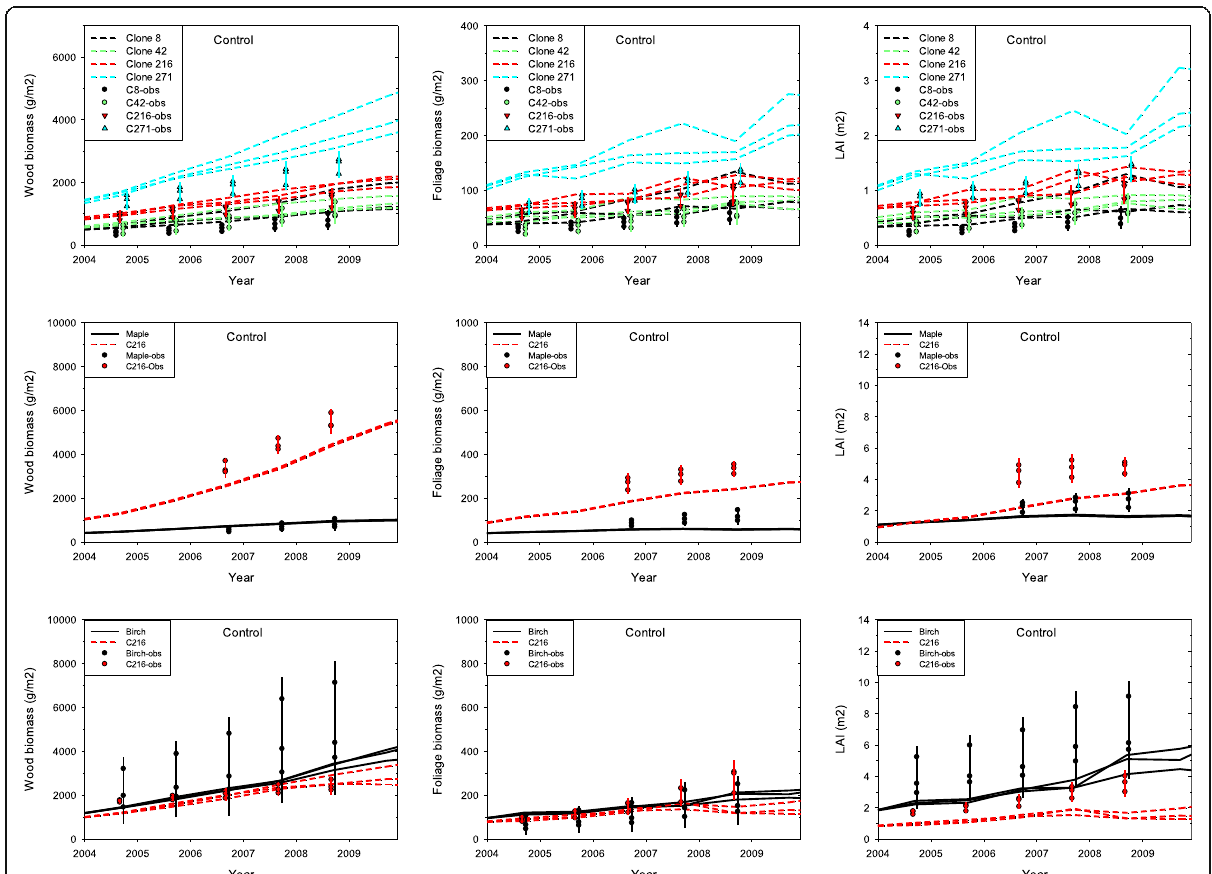
Fig. 1 Comparison of modeled values (dashed lines show each replicate) with empirical observations (symbols) of mid-summer values under ambient (control) conditions. Symbols and 95% confidence intervals (vertical solid lines) are offset to enhance visual clarity ( N =